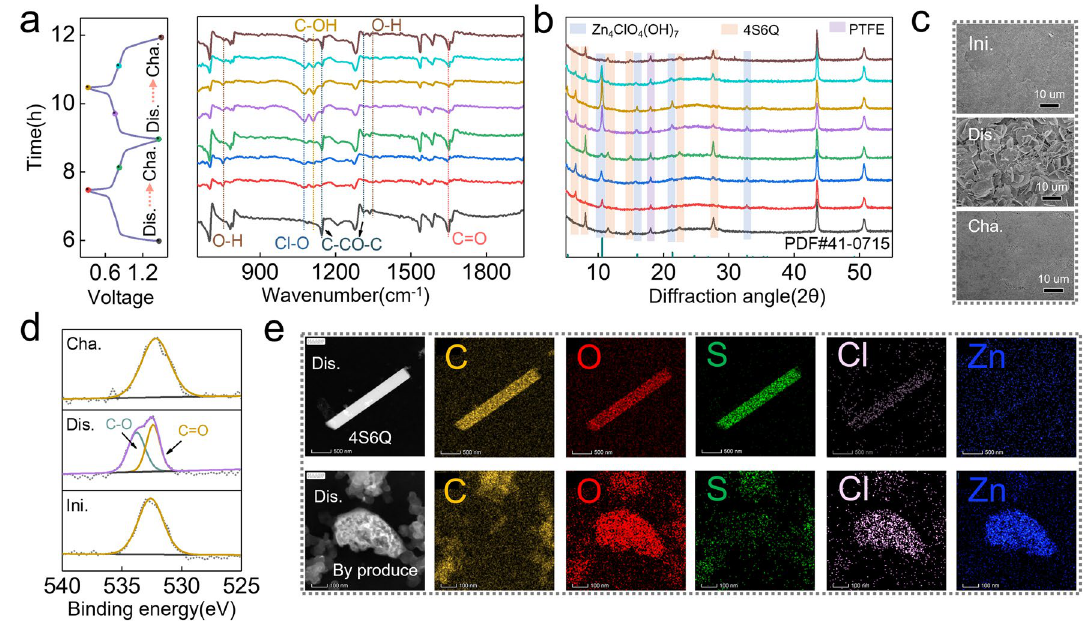
Fig. 5 The charge storage mechanism of Zn//4S6Q. a Ex situ FTIR of 4S6Q electrodes at different states. b Ex situ XRD patterns of 4S6Q elec- trodes at different states. c Ex situ SEM images of 4S6Q electrodes at different states. d Ex situ XPS of O 1 s . e TEM-mapping images of 4S6Q material and by-product at discharged